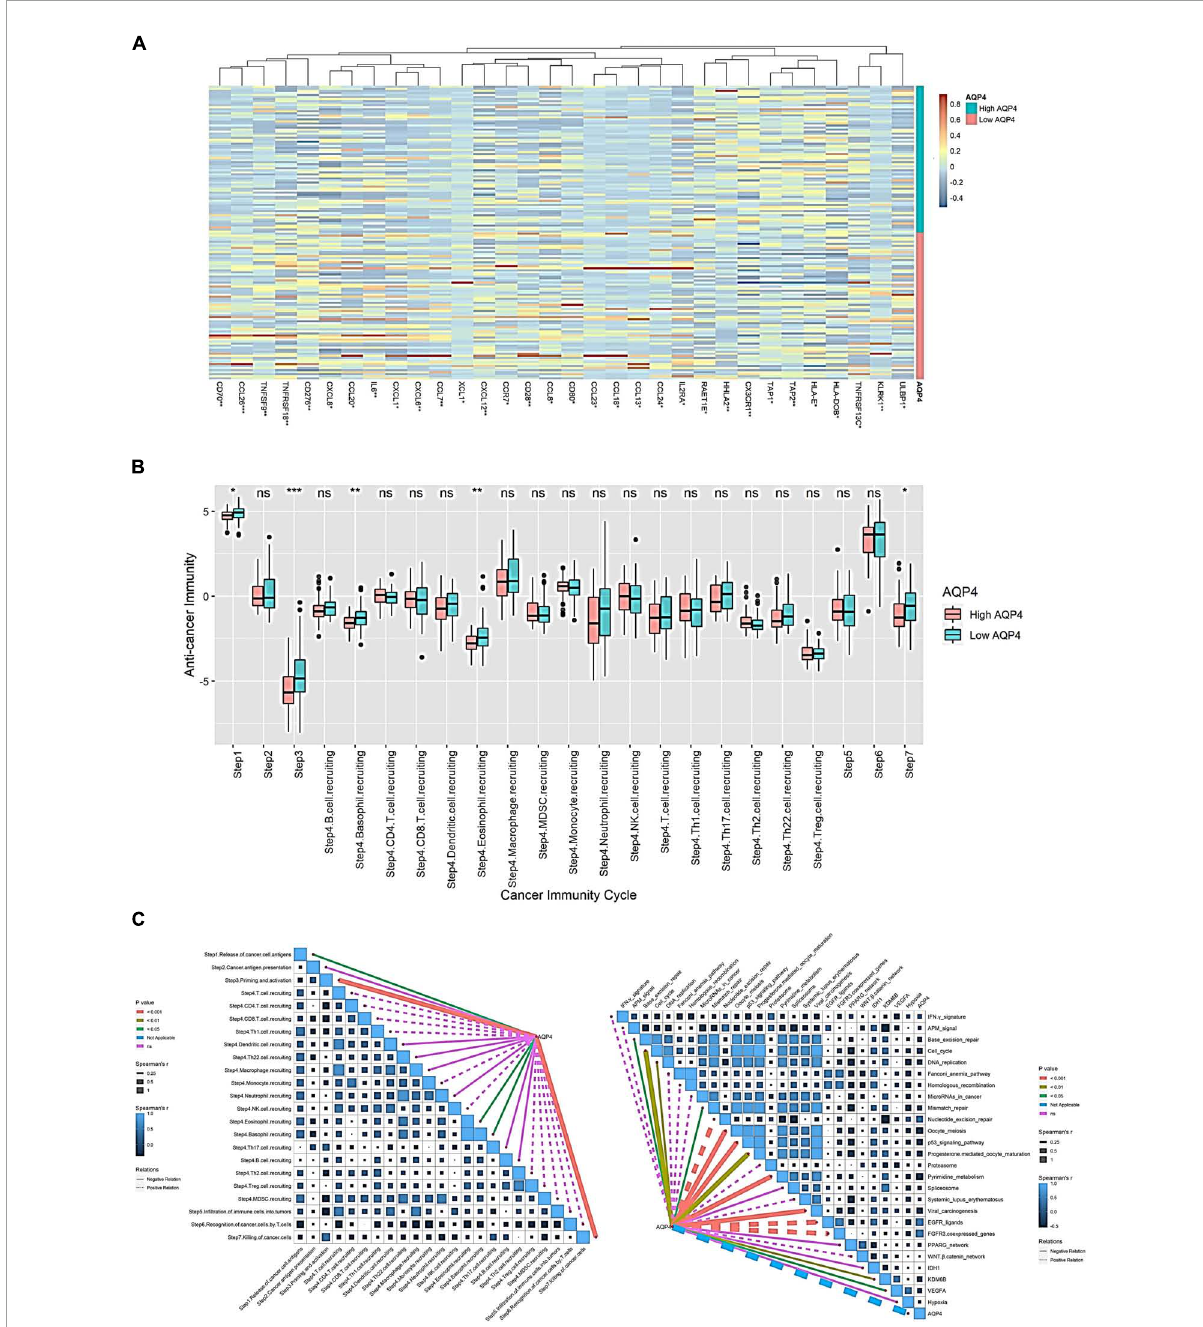
FIGURE3 Effect of AQP4 expression level on immune cell anti-tumor immune process. (A) Differential gene heatmap of immunomodulator-related genes in high and low AQP4 expression groups. (B) The anti-cancer immune process activity was grouped differently in the high and low expression of the AQP4 gene. (C) Correlation analysis of AQP4 gene with immunotherapy-related predictive pathway enrichment score and anti-cancer immune process activity. * p < 0.05, ** p < 0.01, *** p < 0.001.